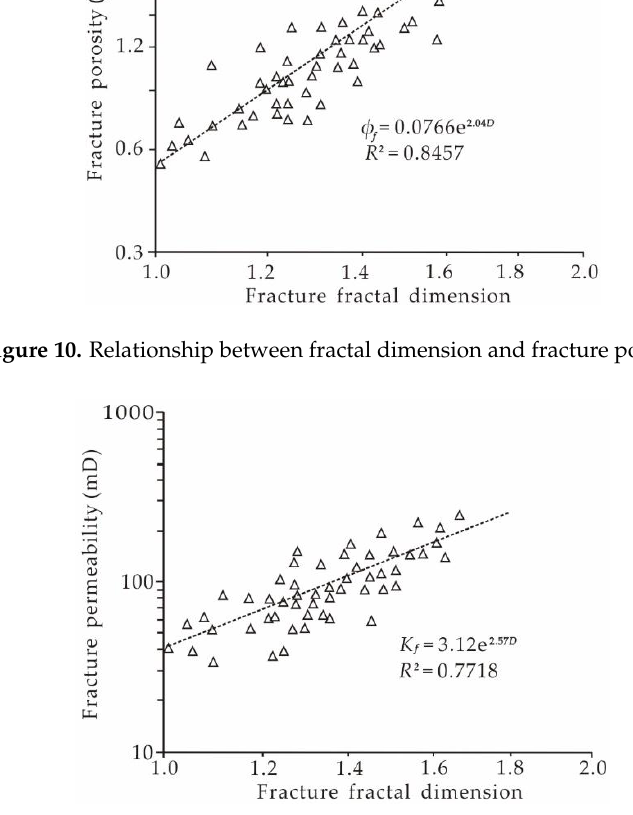
Figure 11. Relationship between fractal dimension and fracture permeability.